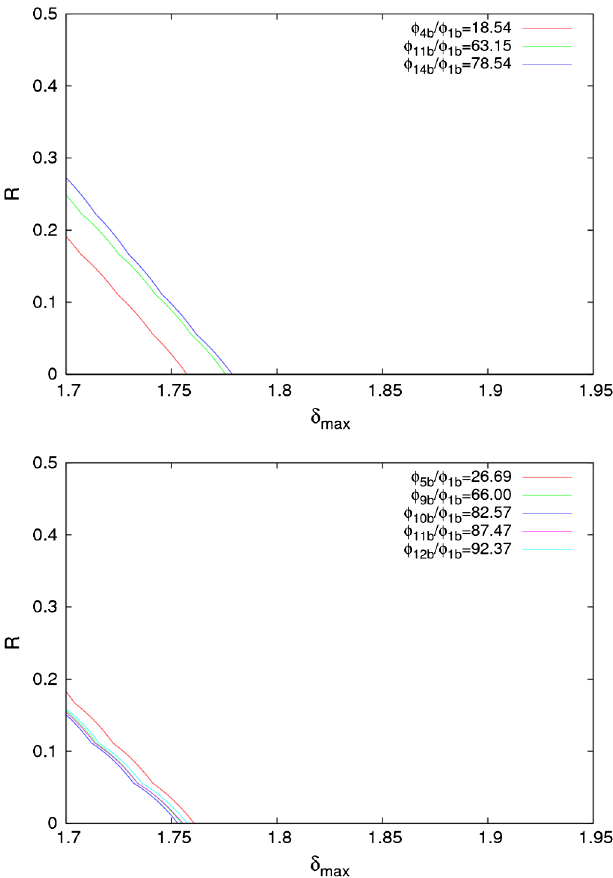
FIG. 5. Combinations of (cid:1) - R values characterizing the max chamber surface, obtained by benchmarking ratios of observed pressure increases against ratios of simulated electron fluxes, for measurements on 11 April (top) and 19 May 2011